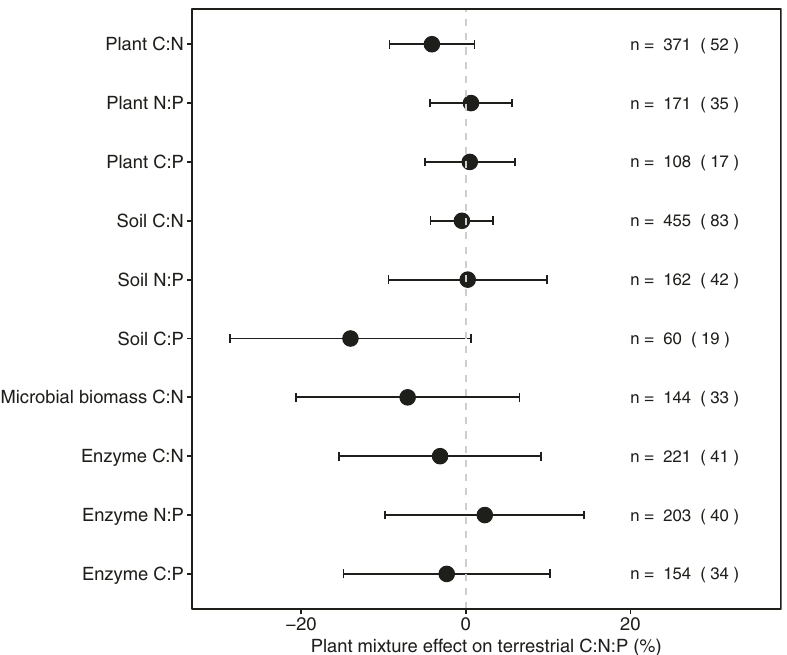
Fig. 2 Comparison of C:N, C:P, and N:P ratios of plants, soils, soil microbial biomass, and enzymes in species mixtures versus monocultures. The effects are quanti fi ed as the percent changes in mixtures compared to the corresponding mean value of constituent monocultures. Values are bootstrapped mean and 95% con fi dence intervals. For each tested C:N:P ratio variable, the number of observations is shown beside each attribute without parentheses with the number of studies in